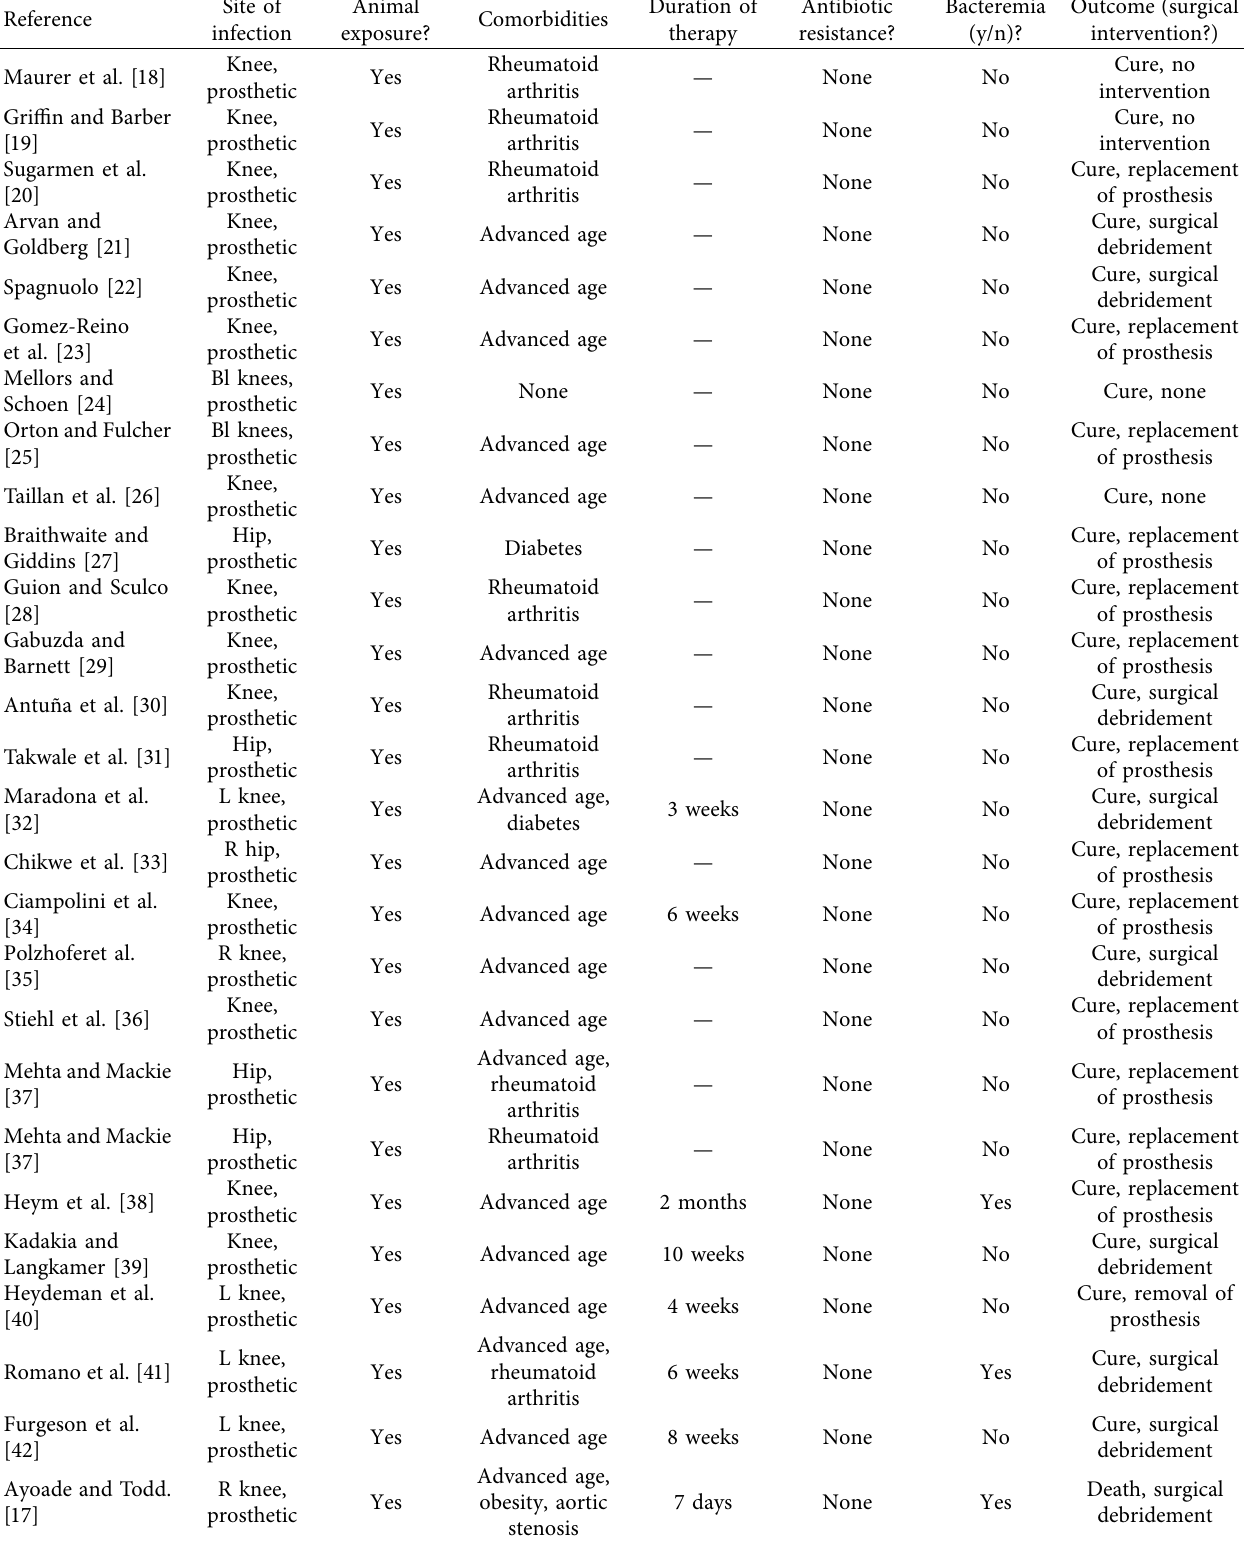
Table 2: Previous findings and outcomes from case reports in relation to the presence of septic arthritis in patients with Pasteurella